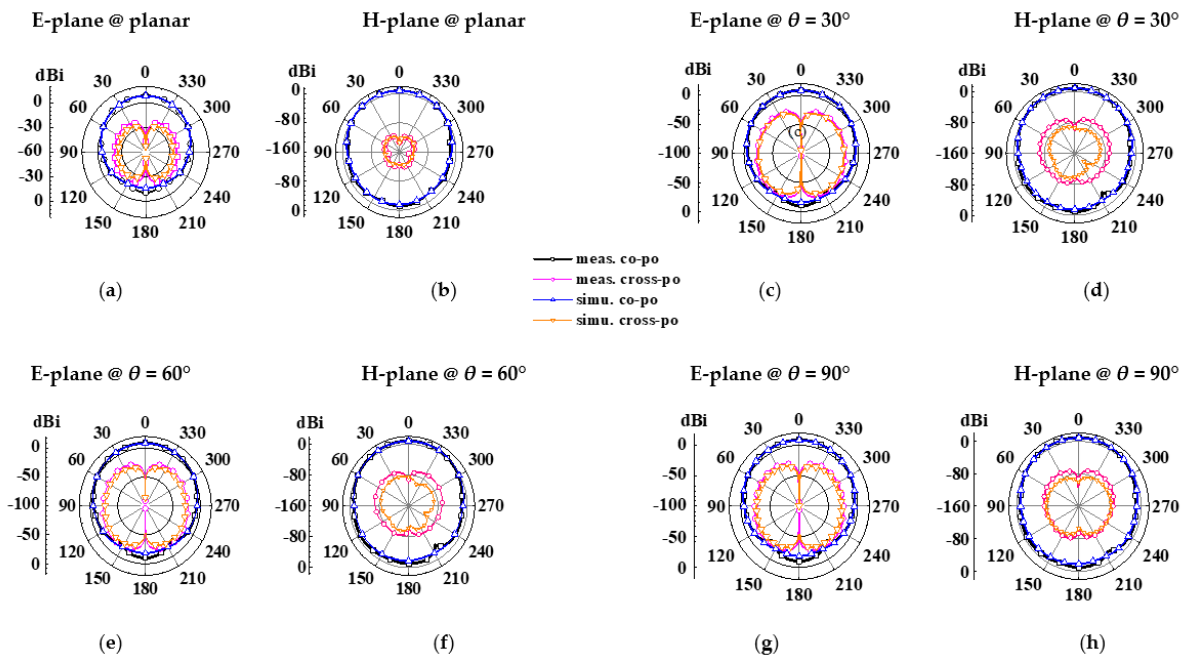
Figure 14. Simulated and measured results for gain radiation patterns and cross-polarization radi-